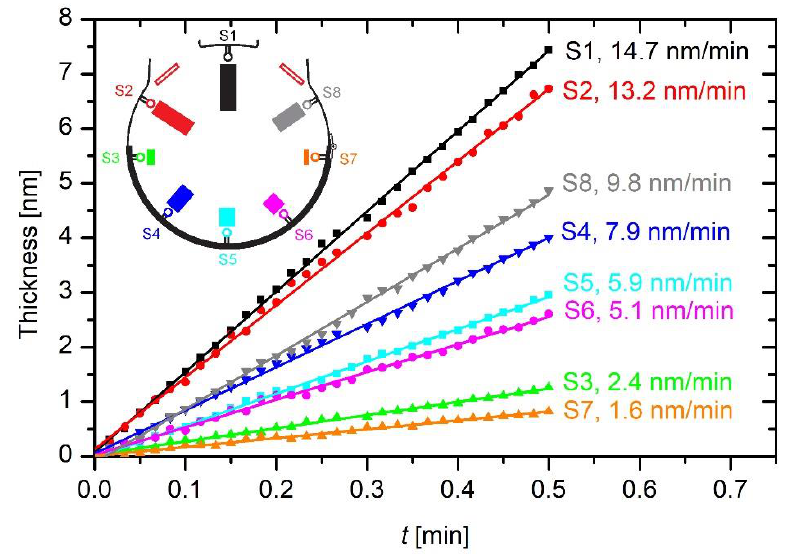
Figure 6. The thickness of the deposited films derived from the sensors’ signals (points) with linear fits (lines) versus the plasma treatment time in an empty reactor at a power of 4 kW at 130 sccm HMDSO. In the inset figure, a deposition rate is presented with the height of the column at a sensor position.